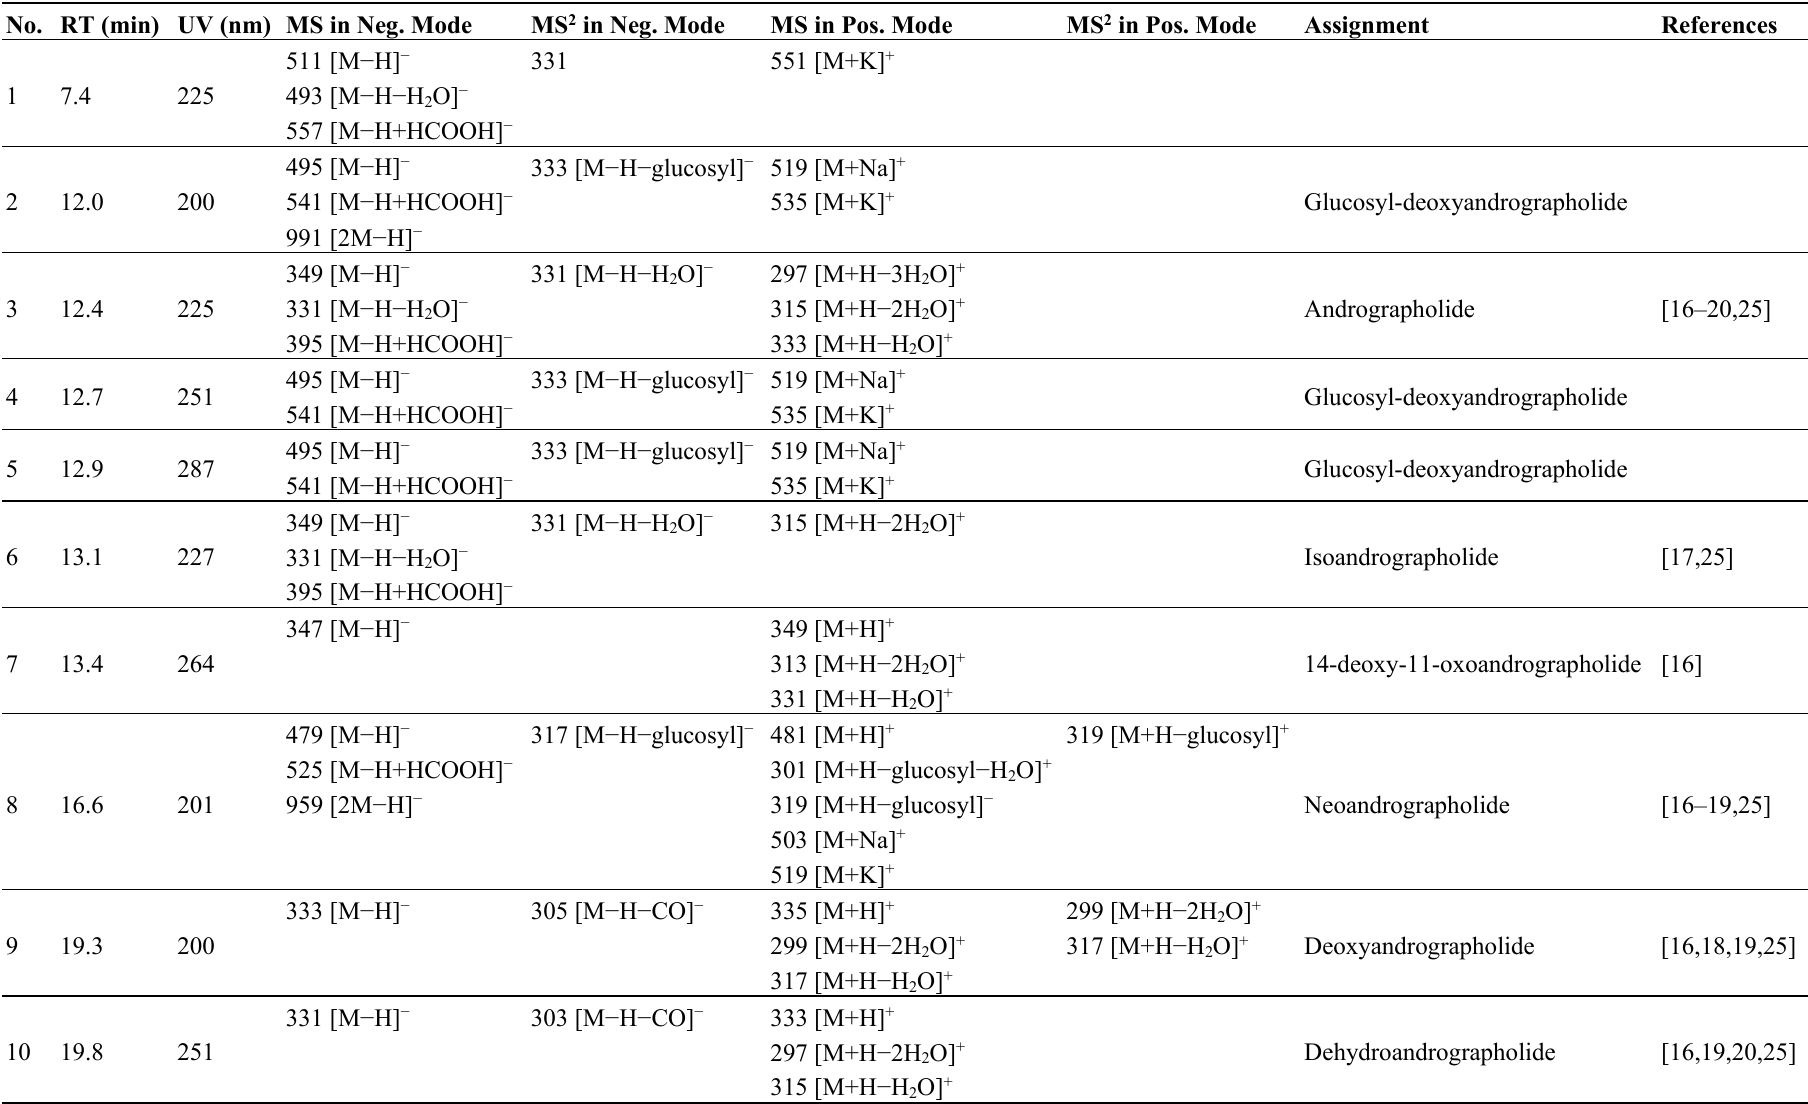
Table 5. Assignment of the characteristic peaks in AH